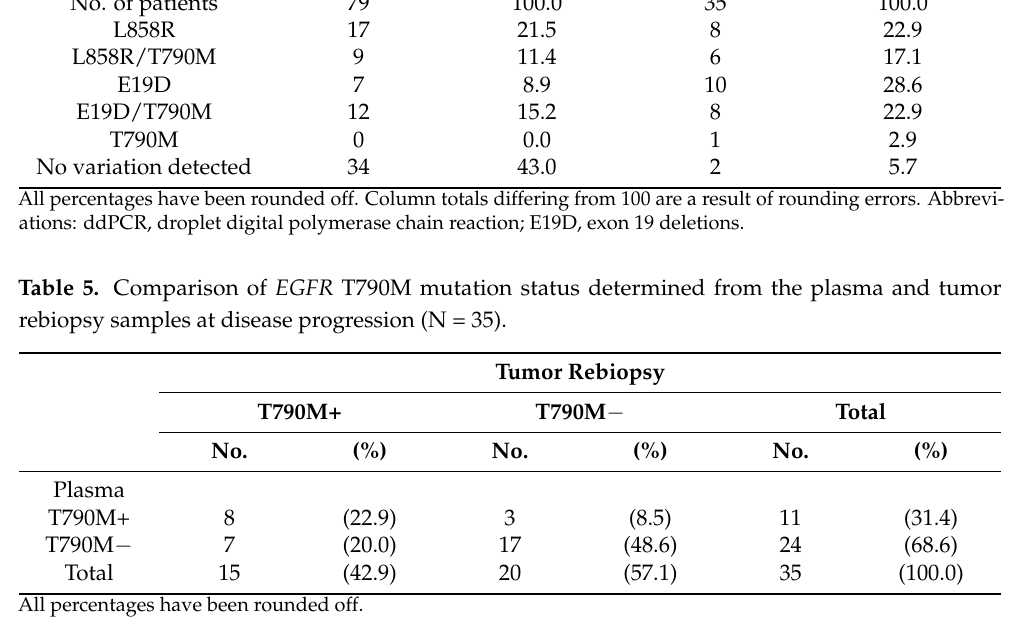
Table 6. Summary of EGFR T790M mutation status in tissue and plasma tested at baseline and disease progression (N =